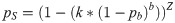
Varying monoclonal antibody 3D11 dose to obtain estimates of probability of protection parameter pb.Mice were injected on each of three consecutive days with varying quantities of the P. berghei sporozoite-neutralising monoclonal antibody 3D11 prior to intravenous challenge with 2000 wild-type P. berghei sporozoites (n = 5–6 per group). (A) A value for the probability of protection parameter pb was obtained by non-linear curve fitting to pS=(1−(k*(1−pb)b))Z, where pS is the probability of sterile protection, b the quantity of 3D11 monoclonal antibody injected, and Z the number of sporozoites used to challenge the mice. (B) An alternative value for pb was obtained by linear regression of a plot of [3D11] versus time to reach 1% blood-stage parasitaemia (obtained by linear regression using daily thin blood smears); pb was calculated from the slope using the equation TV=−log(1−pb)logg*b+TN. (C) Comparison of pb values obtained from (A) and (B), using t-test. Values shown ± SEM.